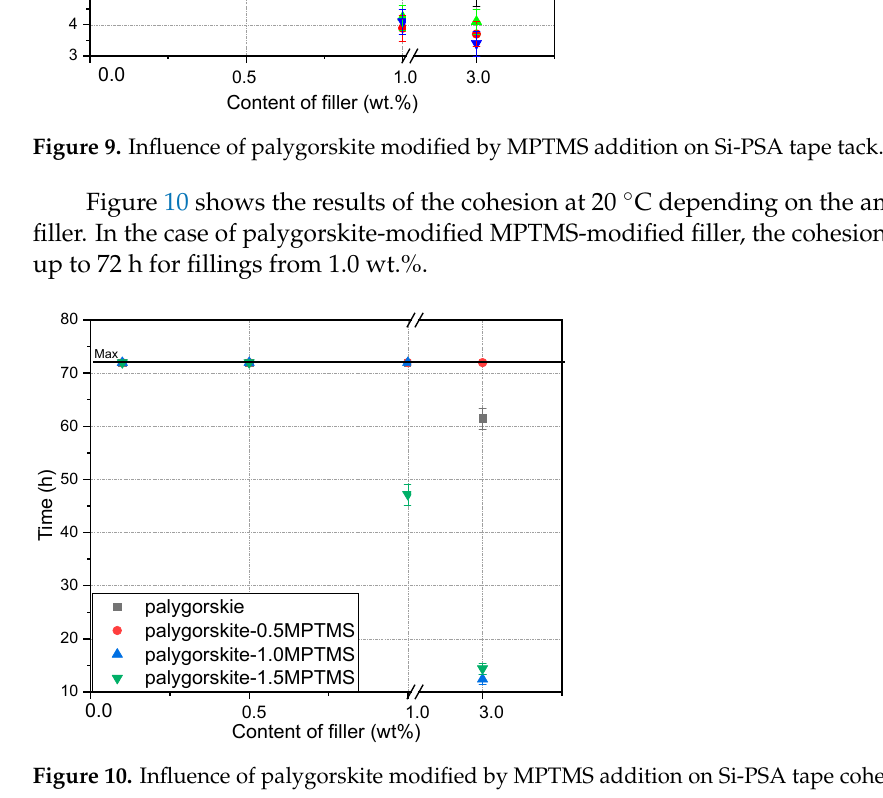
Figure 10. Influence of palygorskite modified by MPTMS addition on Si-PSA tape cohesion at 20 ℃ .